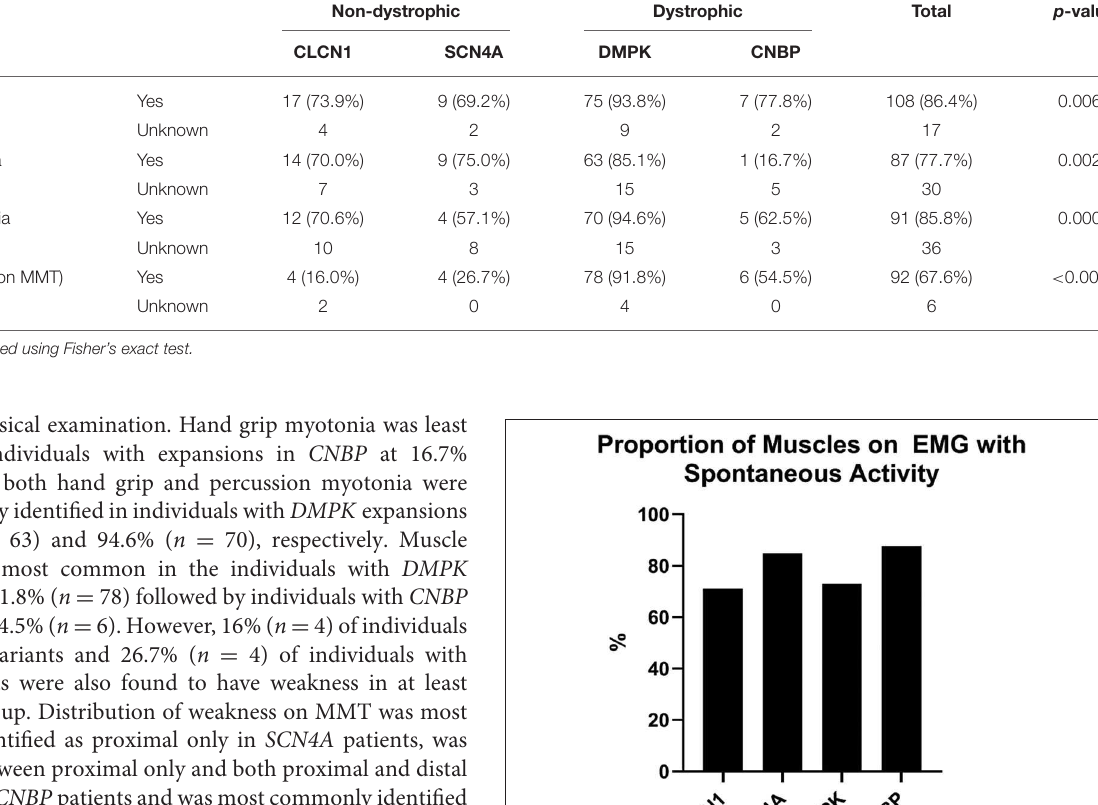
TABLE 6 | Summary of clinical examination findings by genotype. Symptom